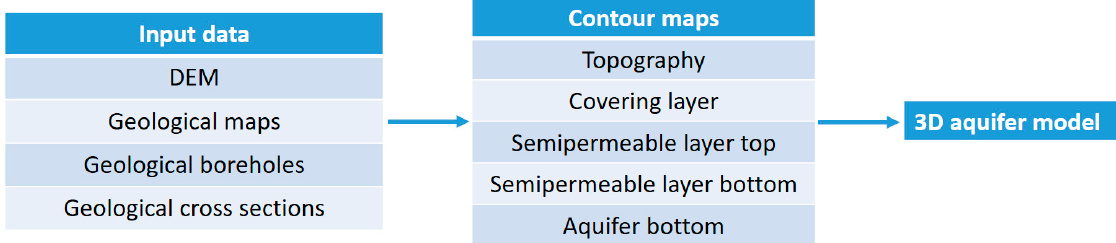
Figure 2. Methodological chart showing the required data and steps in developing 3D model of Varaždin alluvial aquifer.